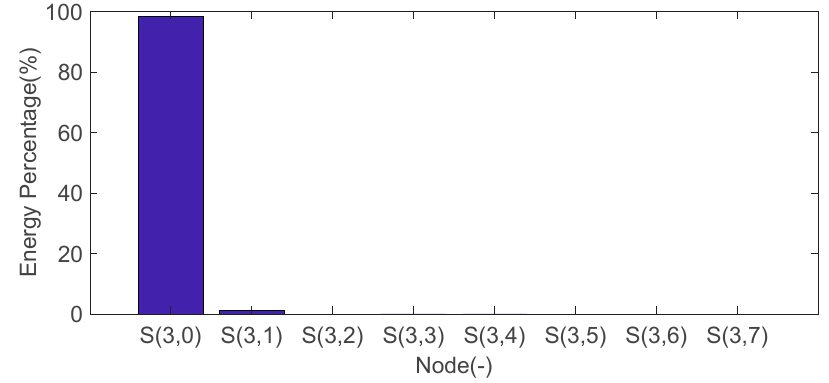
Figure 21. The energy percentage for the reconstructed signal of eight nodes in three layers.